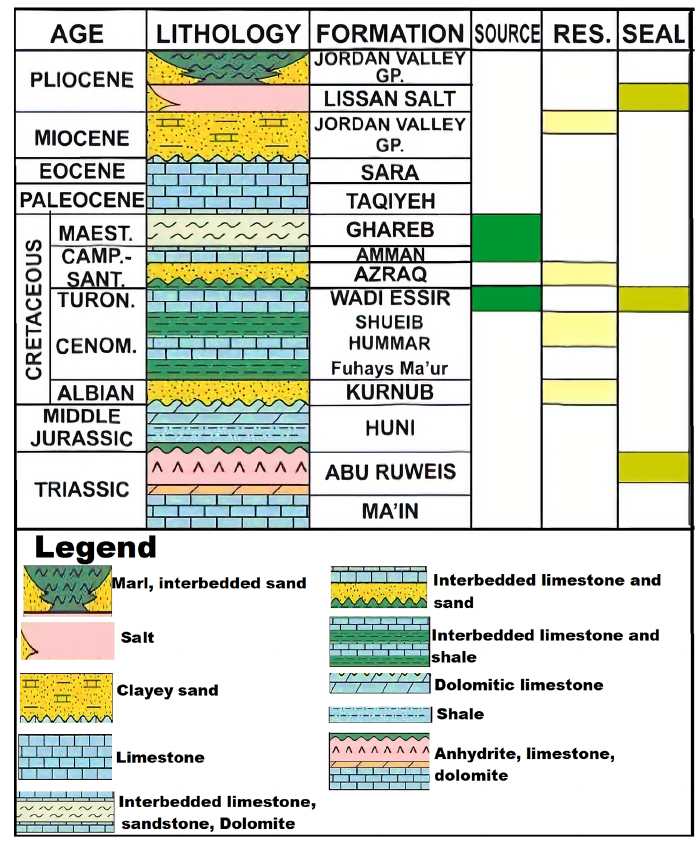
Figure 1. The lithostratigraphic cross section of the Hamzeh field [10].